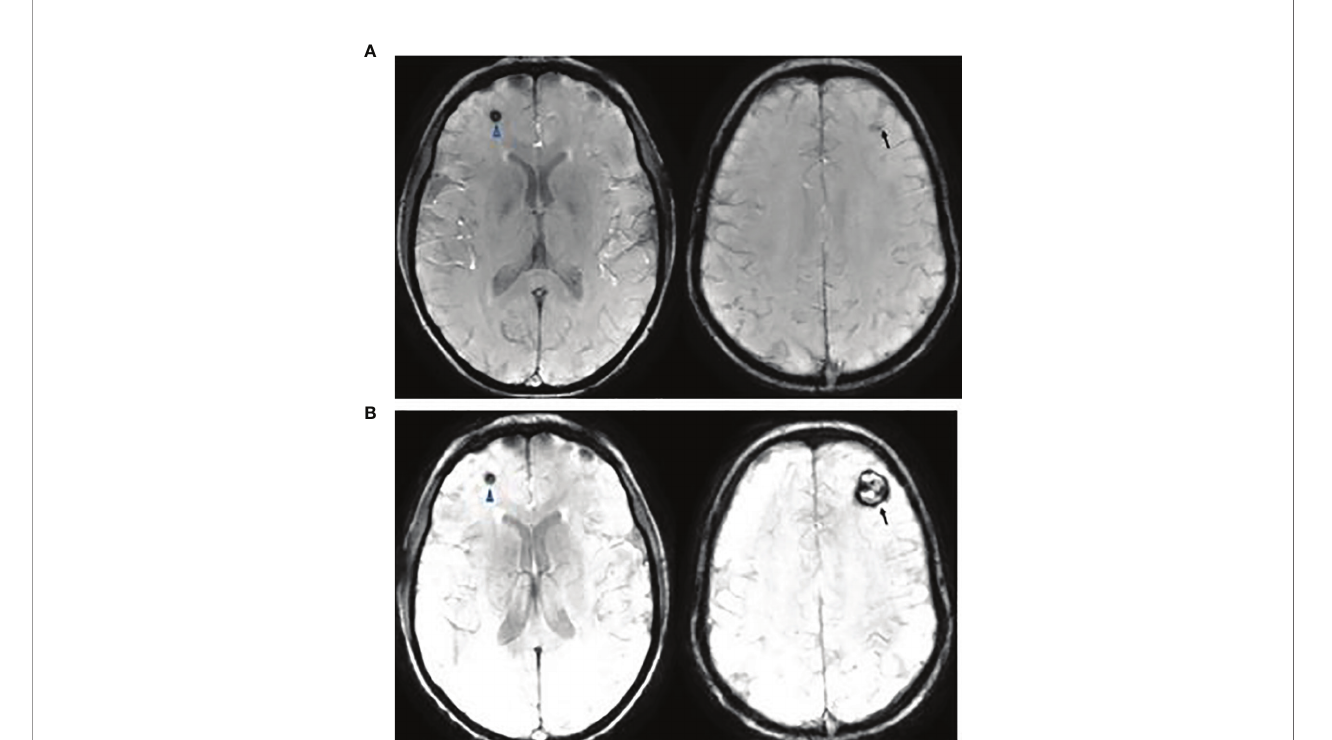
FIGURE 7 | This is a 20-year-old female with medulloblastoma. She had a resection of anaplastic medulloblastoma followed by proton RT (36 Gy to CSI and 55.9 Gy to posterior fossa) and chemotherapy at the age of 10 years. Follow up axial Susceptibility-weighted Imaging, 8 years (A) and 10 years (B) after the therapy, showing interval increase of cavernyus angioma of the left frontal lobe (arrow) but a stable lesion in the right frontal lobe (arrowhead). She presented with increasing headaches which were resolved following a resection of left frontal cavernous